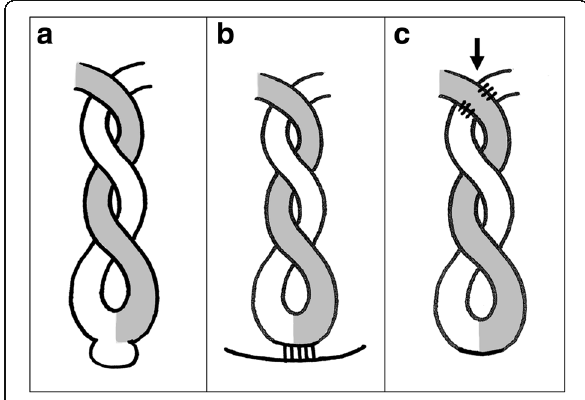
Fig. 3 The classification of volvulus. a The proximal and distal bowel are twisted like a torsion pendulum by an abnormality such as a tumor. b The proximal and distal bowel are rotated on an axis formed by a fixed point on the abdominal wall. c Volvulus occurs due to the adhesion (arrow: torsion origin) of the proximal and distal bowel or the adhesion of the bowel and